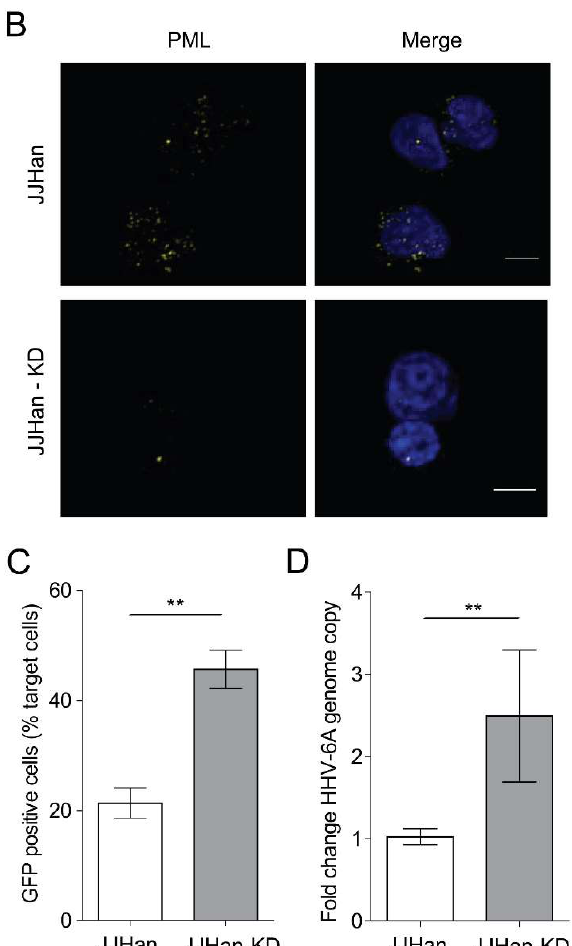
Figure 2. Effect of ND10 complex knockdown in JJHan cells on HHV-6A replication. ( A ) PML and hDaxx knockdown were assessed in two independent knockdown JJHan clones by western blotting. ( B ) PML knockdown was confirmed in JJHan clone 6 by indirect immunofluorescence against PML protein (yellow). Representative images are shown where the nuclei were stained with DAPI (blue) (scale bars correspond to 3 μm). ( C ) Flow cytometry analysis to quantify the number of GFP expressing cells upon infection of JJHan or JJHan-KD clone 6. Results are shown as the mean of three independent experiments with standard errors (**, p < 0.01). ( D ) qPCR analysis to determine the HHV-6A genome copies in infected JJHan and JJHan-KD clone 6 cells. Results are shown as the mean of five independent experiments with standard errors (**, p < 0.01).